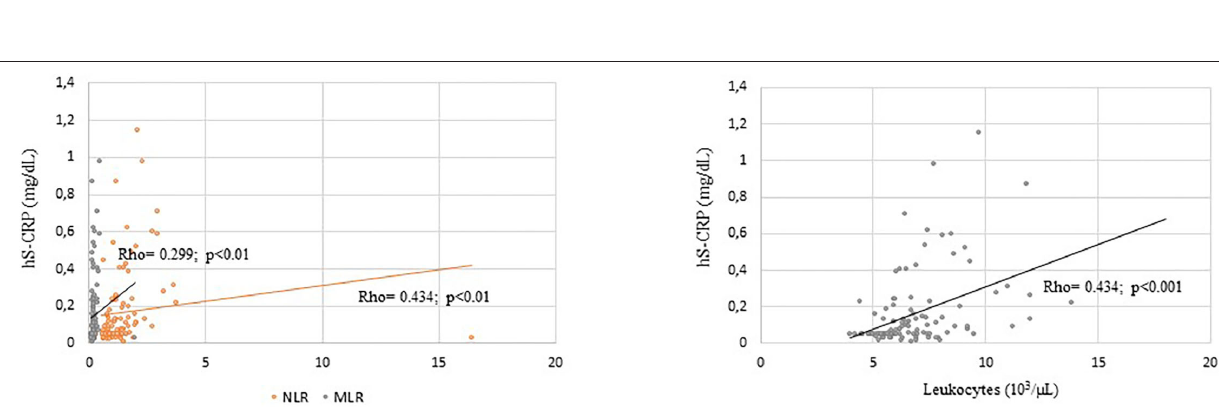
FIGURE 2 | Significative correlation coefficients between hs-CRP (mg/dL) and inflammatory markers in OW/OB boys.